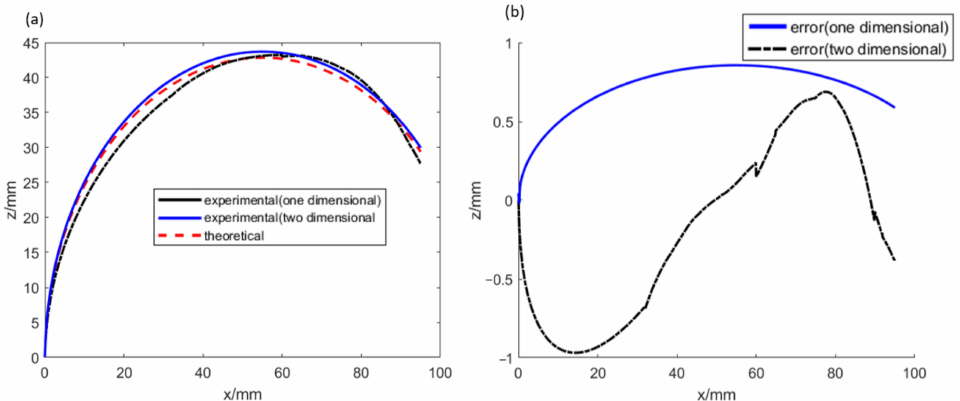
Figure 8. Cross-sectional height distributions of contour and the measurement error. ( a ) Height distributions of contour and ( b ) error